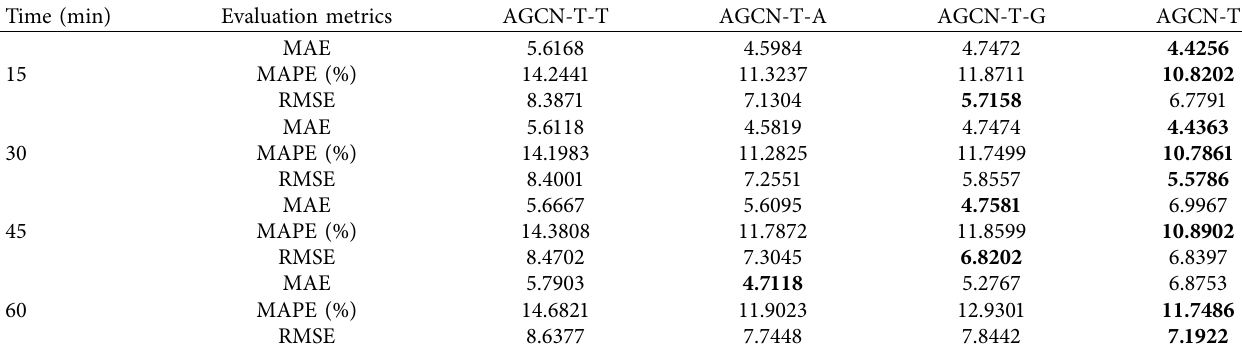
Table 6: Performance of variants of AGCN-T on PeMSD7.